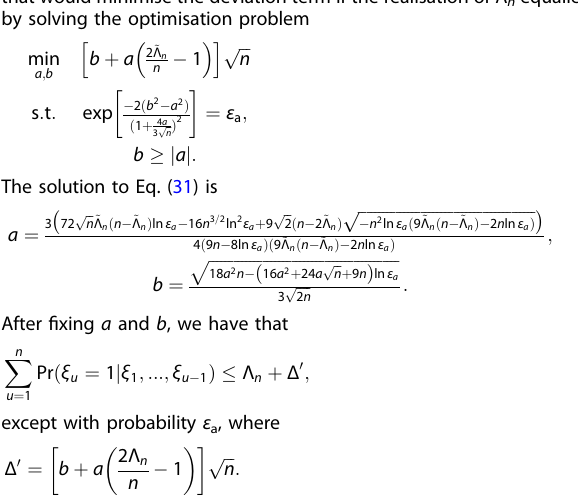
ffiffiffiffiffiffiffiffiffiffiffiffiffiffiffiffiffi 1 n ln ε (cid:2) 1 2